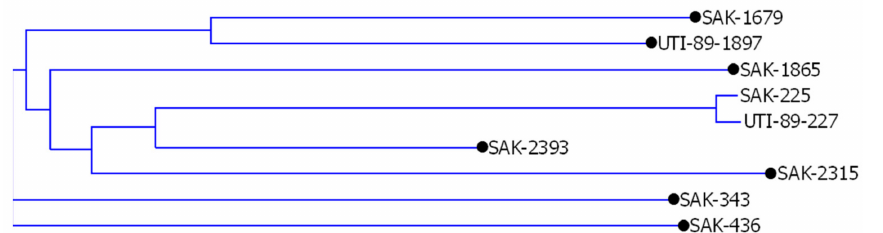
Figure 5. Sequence similarity analysis of the 3 (cid:48) -CCG n ≥ 3 and 5 (cid:48) -TCG n ≥ 3-flanked sequences extracted from the UTI89 and O157:H7 Sakai genomes. Black dots mark